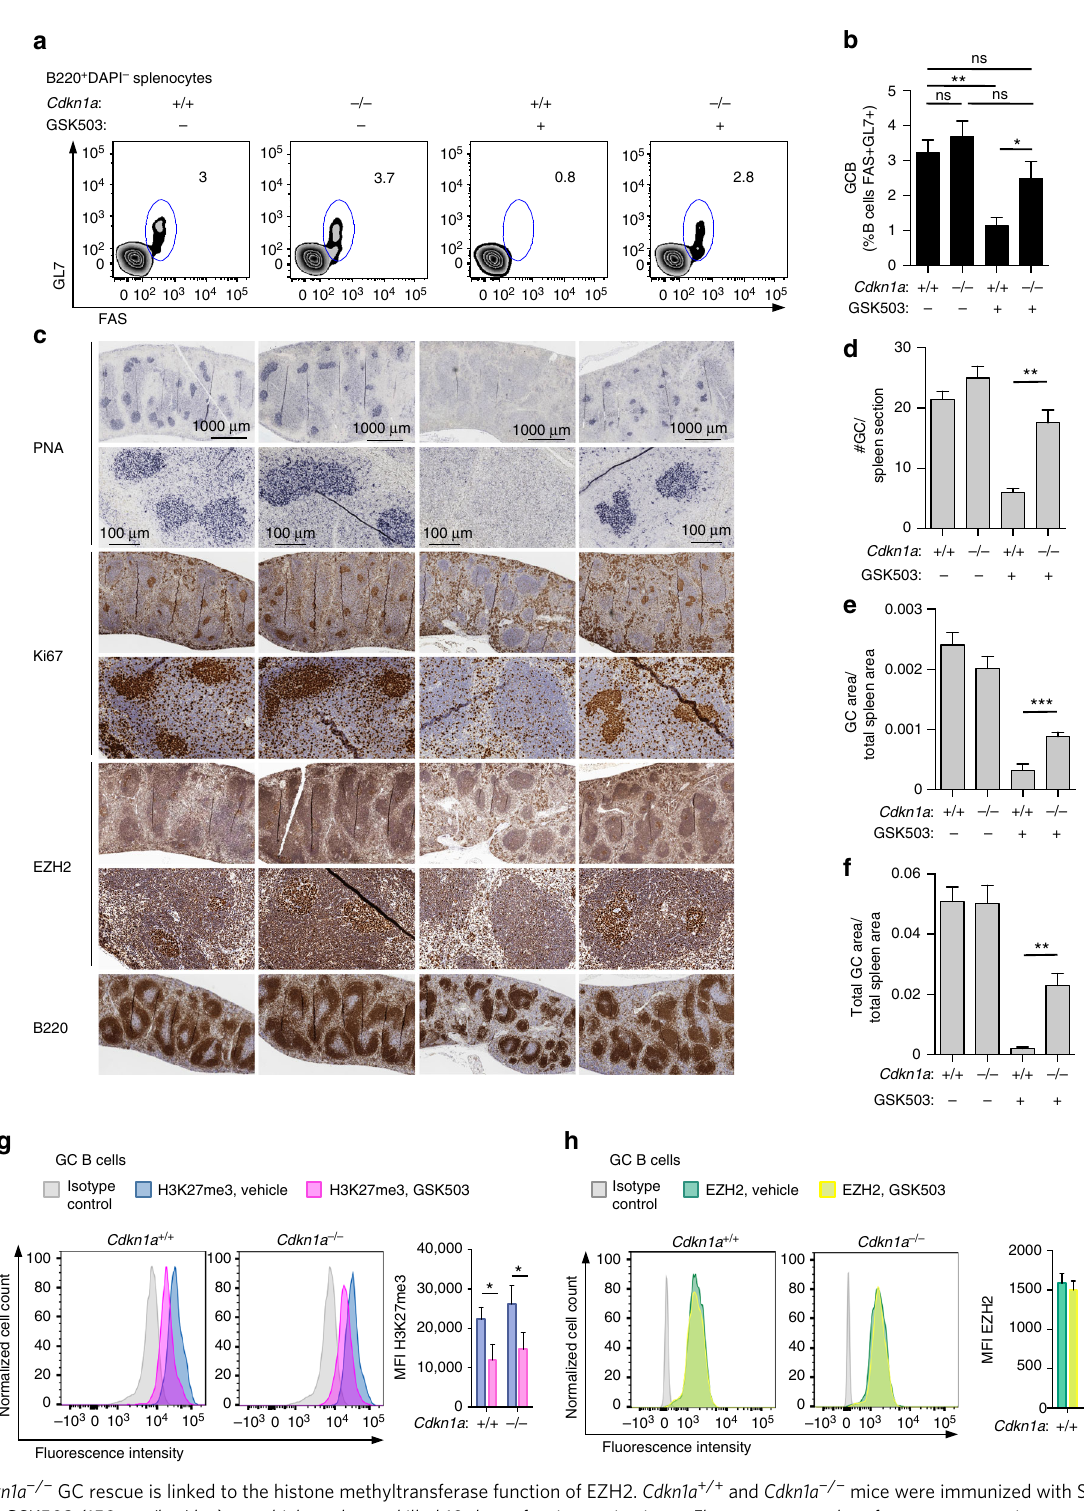
Fig. 2 Cdkn1a − / − GC rescue is linked to the histone methyltransferase function of EZH2. Cdkn1a +/+ and Cdkn1a − / − mice were immunized with SRBC, treated daily with GSK503 (150 mg/kg/day) or vehicle and were killed 10 days after immunization. a Flow cytometry plot of one representative mouse spleen per group. The gated area shows the percentage of GC B cells (GL7 + FAS + ) within live B cells (B220 + DAPI-, see Supplementary Fig. 2A for gating strategy). b Average of GC B populations of each group of mice quanti fi ed by fl ow cytometry as in a ( n = 5 mice per group). c Formalin fi xed paraf fi n embedded splenic tissue was stained for PNA, Ki67, EZH2, and B220. One representative picture of three spleens analyzed per group is shown. d – f Quanti fi cation of PNA staining from c ( n = 3 spleens per group, see Fig. 1d – f). g , h Splenocytes from 4 WT and 4 Cdkn1a − / − mice were permeabilized and stained for GC B cells (GL7 + FAS + B220 + , see Supplementary Fig. 2A for gating strategy) and H3K27me3 g and EZH2 h using fl uorochrome-conjugated anti H3K27me3 and anti EZH2 antibodies, respectively. The histograms depict the mean fl uorescence intensity (MFI) ± SD of H3K27me3 and EZH2 per group of mice. Values in b , d , e , f are shown as mean ± SEM. t test, * P < 0.05, ** P < 0.01, *** P < 0.001. Results are representative of a total of three independent experiments performed with different cohorts of mice. See also Supplementary Fig.